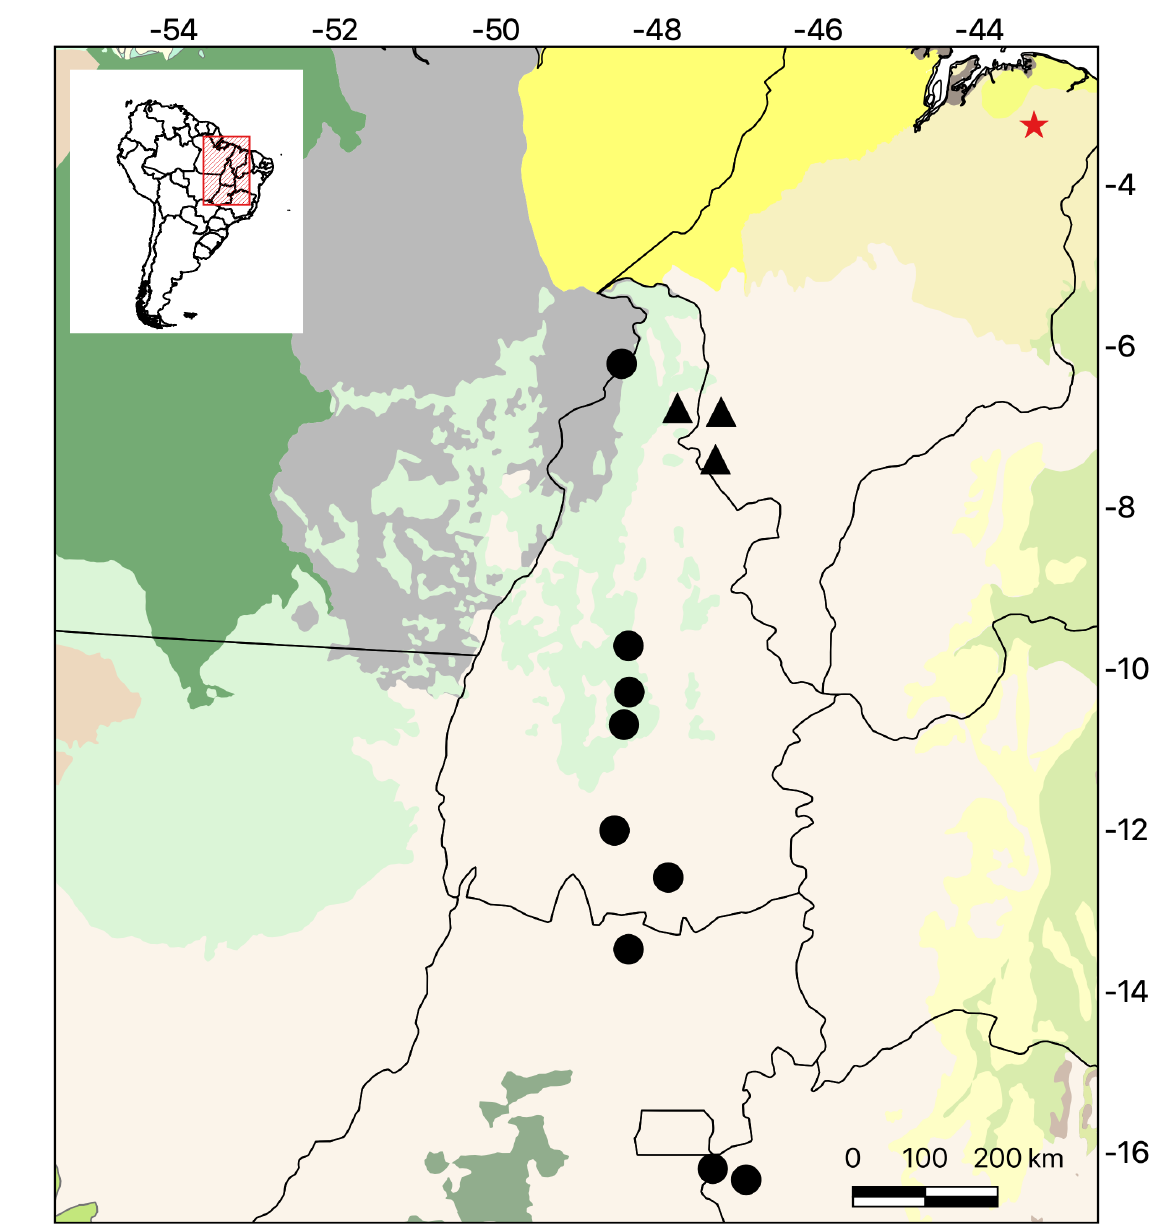
Figure 1. Distribution of Trilepida fuliginosa in Brazil (MPEG 21523). Symbols: black circles: literature records; black triangle mark: literature records from Prudente et al. (2019), with identification not confirmed by TBG; red star: new record in Santo Amaro Farm, municipality of Urbano Santos, state of Maranhão (MPEG 21523). Ecoregions with point occurrence according to Dinerstein et al. (2017): Babaçu 043.4164 ° W; 41 m a.s.l.; 08 Feb. 2003; Cláudia M. Maia